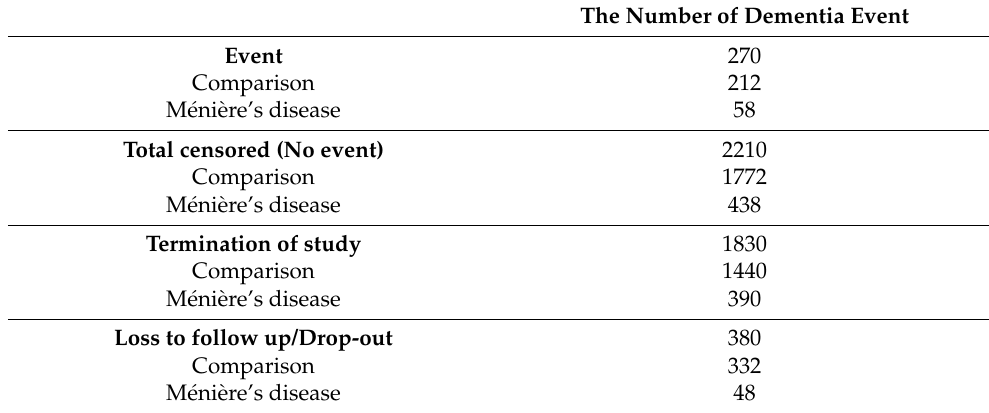
Table 1. Description of time to event and censored